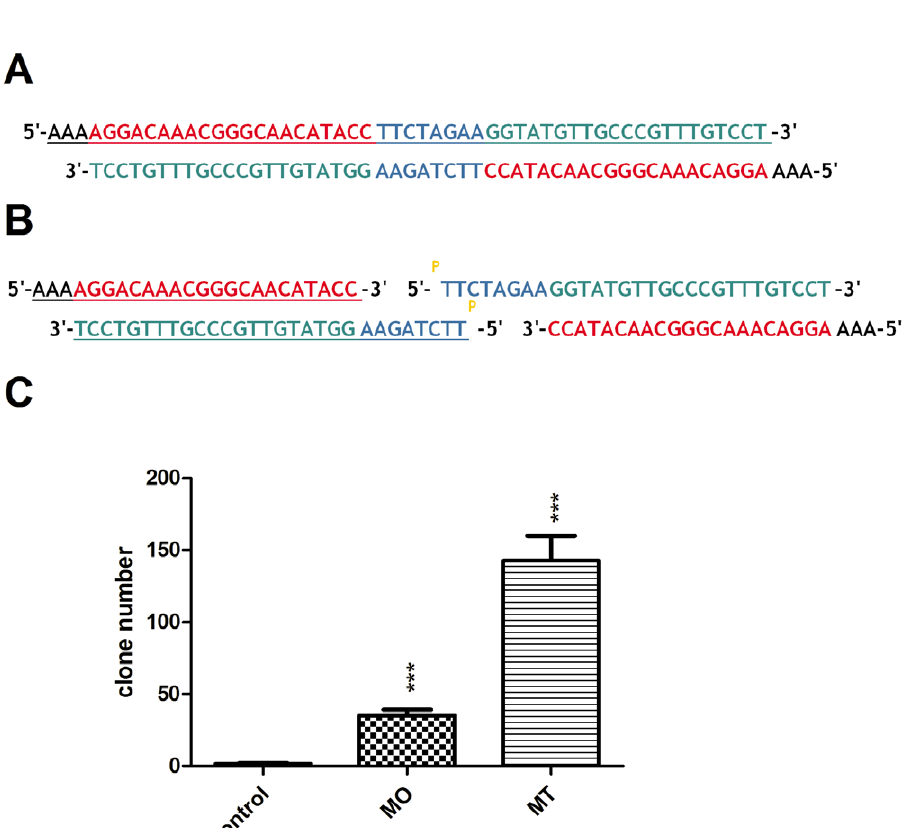
Figure 3. Comparison of the two shRNA construction methods. (A) The shRNA clone method based on one long oligonucleotide (MO). The oligo underlined was synthesized and annealed to its self to form double strands. (B) The shRNA clone method based on two short oligonucleotides (MT). Two short oligonucleotides (underlined) were synthesized and the 5’-end of the oligo containing the loop sequence (TTCTAGAA) phosphorylated by the T4 polynucleotide kinase in the presence of ATP. Then, the two short oligonucleotides were annealed to form double strands. (C) The shRNA cloning efficiency of the two methods was compared. The vector pshOK-basic was digested with Sap I and ligated with the annealed double strand oligos as described above. The ‘‘control’’ group represents the linearized pshOK-basic ligated in the absence of oligos. Means and standard deviations were generated from 3 independent experiments.